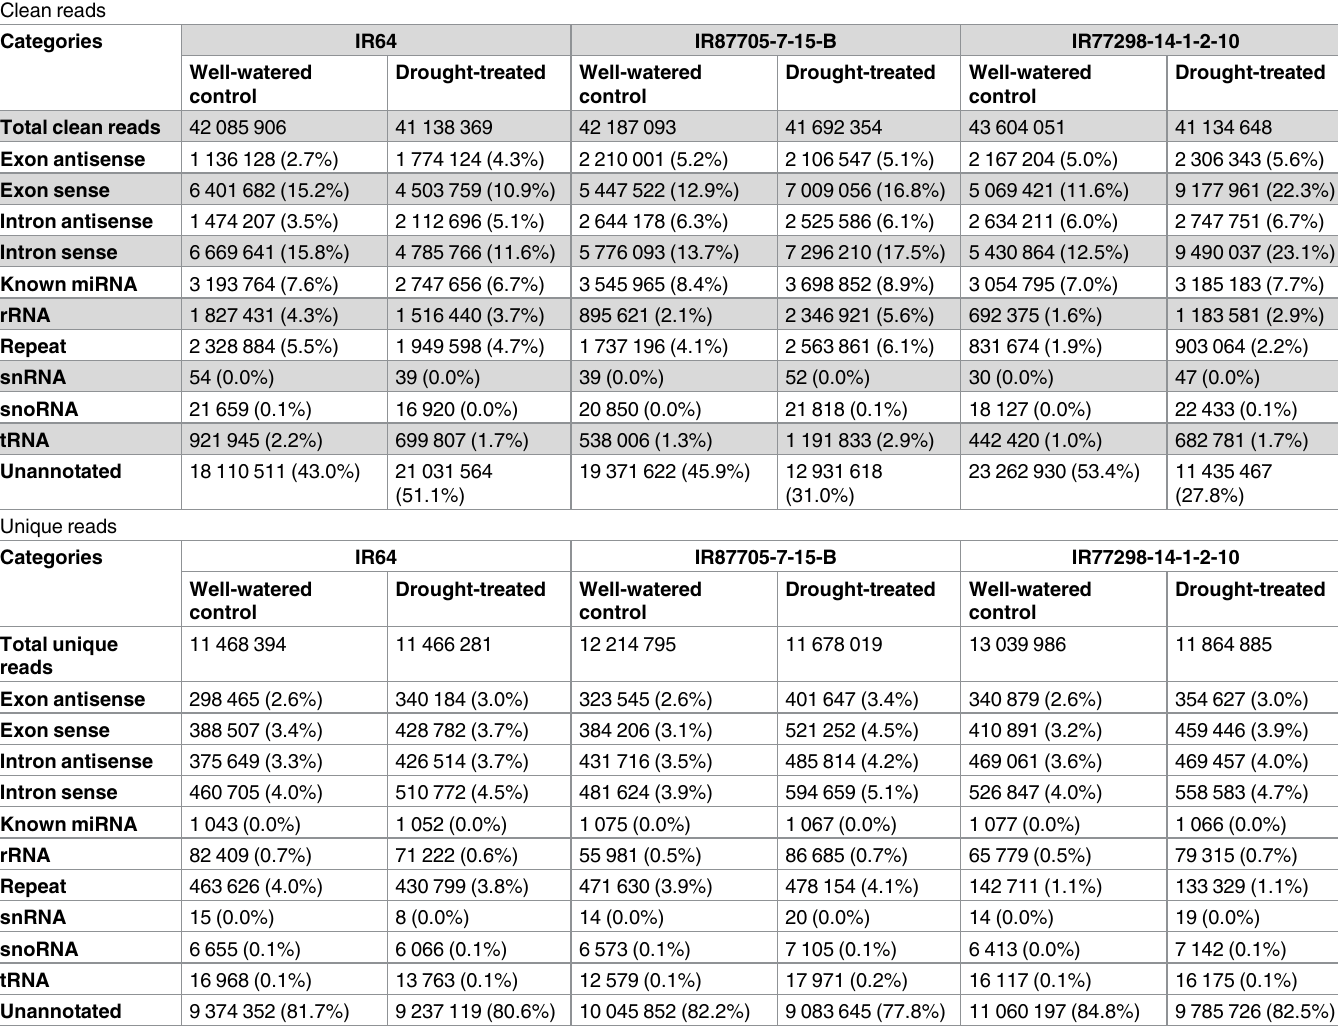
Table 2. Summaryof clean reads and unique reads mapping to different publicly available